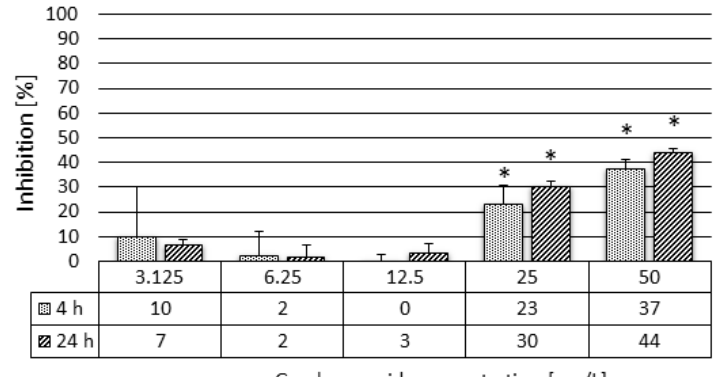
Figure 5. Inhibition of feeding activity of D. magna exposed to GO for 48 h after 4 h and 24 h of a recovery period in clean growth medium. Significant effect when compared to the control is marked by an asterisk (*).